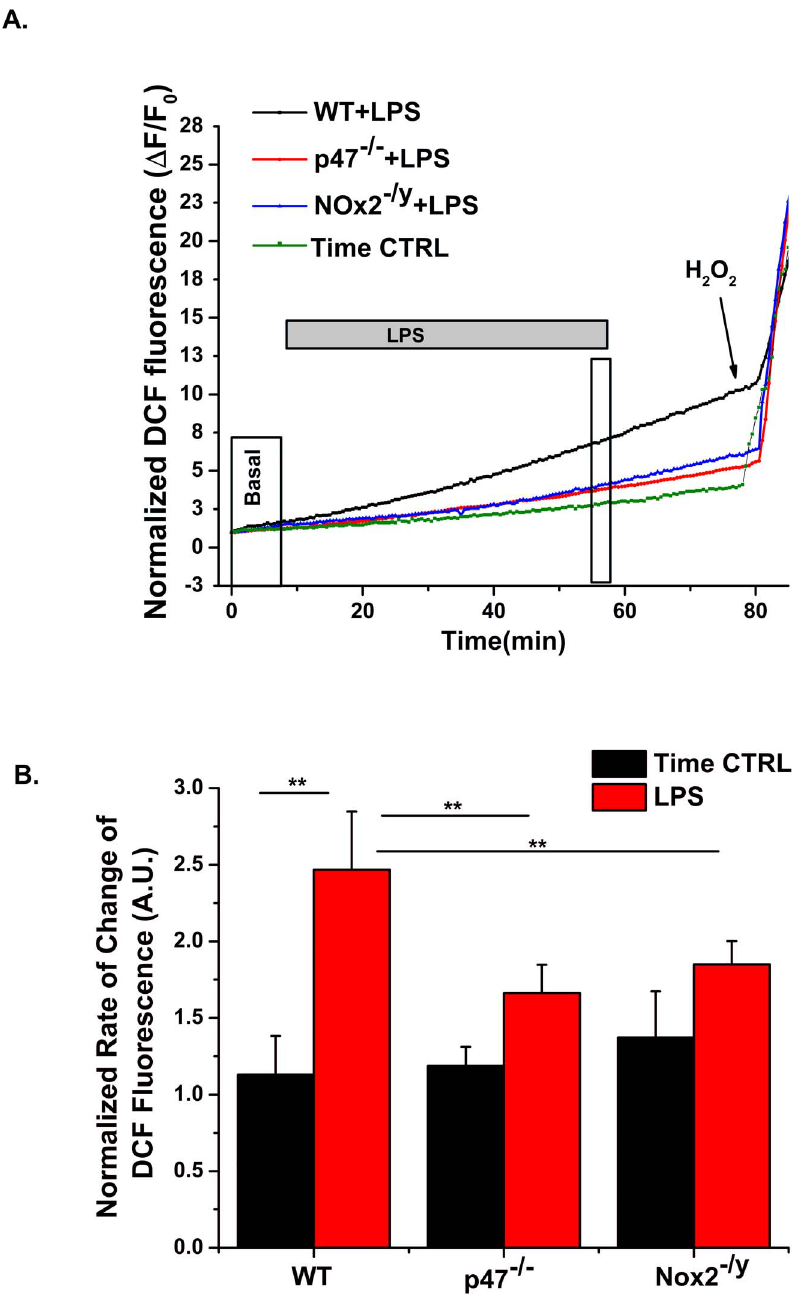
Figure 3. LPS-induced stimulation increases the rate of DCF fluorescence in macrophage cells from 8–10 wk old mice. (A) Representative data ( D F/F 0 ) from macrophages of WT (C57Bl/6J, black line), p47 phox 2 / 2 (red line) and Nox2 2 /y (blue line) mice showing the temporal change in DCF fluorescence upon LPS-treatment (20 ng/ml). F 0 is the basal fluorescence taken over the first 100 seconds prior to LPS. (B) LPS-induced stimulation (boxed areas of A) significantly increased the normalized rate of DCF fluorescence (black bar) compared to pre-stimulated values (white bar). The increased intensity of DCF fluorescence was significantly higher in WT macrophages compared to macrophages from p47 phox 2 / 2 and Nox2 2 /y mice. Error bars represent s.e. from the mean. Data are analyzed from n animals =6 per strain, 6 replicates per animal. * p , 0.05 (Tukey statistical analysis for p value). frequency of 1 Hz with a square pulse stimulator (S48; Grass Technologies, West Warwick, RI). FDB muscle fibers were Mice were deeply anesthetized by isofluorane (2%) inhalation isolated 6–8 days later. Typically, the right foot was electroporat- and euthanized by rapid cervical dislocation. FDB muscles were ed, while the left foot served as a contra-lateral control. surgically isolated and incubated in minimal essential media containing 0.1% gentamycin and 0.4% Collagenase A (Roche